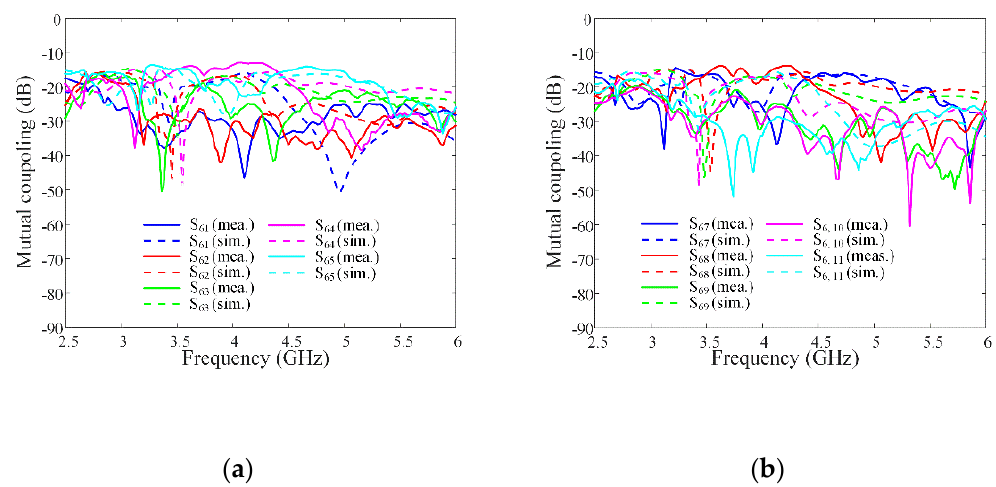
Figure 9. The measured and simulated mutual couplings: ( a ) the mutual couplings for port 1 to port 5; ( b ) the mutual couplings for port 7 to port 11. Figure 10 shows the beam steering characteristics with steering angles, θ 0 , of 0° and 15° at 4 GHz and 5 GHz. The solid and dashed lines indicate the measurements and sim- ulations, and the blue and red lines denote the radiation patterns of the co- and cross- polarization. The measured and simulated results are well matched to each other. The measured bore-sight array gains of the co-polarization are 13.4 dBi and 13.7 dBi at 4 GHz and 5 GHz, and those of the cross-polarizations are − 4.9 dBi and − 3.4 dBi, respectively. When the beam is steered at the steering angle, θ 0 , of 15°, the maximum measured array gains of the co-polarization are 12.2 dBi and 10.3 dBi at 4 GHz and 5 GHz, respectively. Moreover, the co-and cross-polarization level differences at the angle of the maximum gains are 14 dB at 4 GHz and 11.4 dB at 5 GHz. Note that these beam steering results were calculated considering the ideal gain increment of the 11 elements from the bore-sight gains of 3.5 dBi at 4 GHz for the center array element. In addition, the measured back lobe levels seem to be higher than the simulated results because the extra obstacles, such as a RF cable and a positioner structure in the measurement setup, caused high back lobe lev- els. These results confirm that the proposed array antenna sensor can be applied to high- power jamming applications, as it is capable of achieving essential and required array performances. We also compared the antenna characteristics between the proposed array and the reference wideband arrays; the detailed explanations are listed in Table 3.